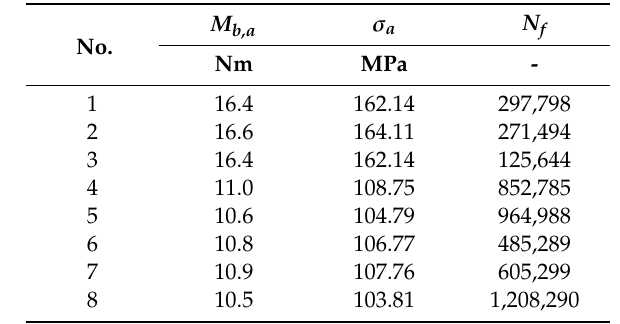
Table 4. Results of fatigue tests of samples after 7 days of immersion in a 3.5% NaCl solution in tap water.